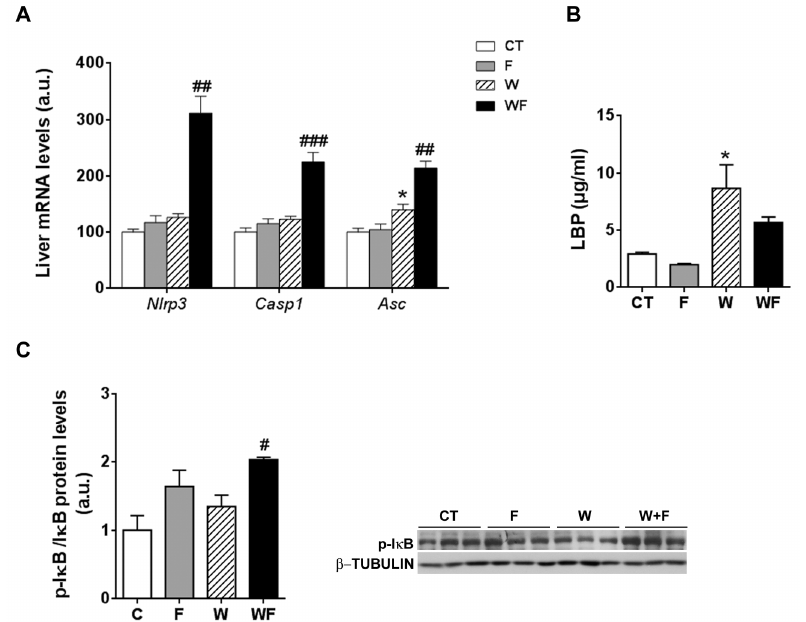
Figure 3. ( A ) Bar plots showing the relative levels of specific mRNAs of the NLRP3 inflammasome complex from Control (CT, mice fed standard solid-chow), Fructose (F, mice fed standard solid-chow plus a 15% fructose solution ad libitum), Western (W, mice fed Western solid-chow), and Western + Fructose (WF, mice fed Western solid-chow plus a 15% fructose solution ad libitum), represented as mean (a.u., arbitrary units) ± SEM of five different liver samples; ( B ) Plasma level of lipopolysaccharide (LPS)-binding protein represented as mean ( µ g/mL) ± SEM of five to six different plasma samples obtained from CT, F, W and WF groups; ( C ) Western-blot of phosphorylated and total I κ B α in liver samples obtained from CT, F, W and WF groups. Representative bands corresponding to three different mice in each group are shown; bar plots show the level of the phosphorylated protein expressed as the mean (a.u., arbitrary units) ± SEM of the values obtained from three to four animals. * p < 0.05 vs. CT values; # p < 0.05, ## p < 0.01, ### p <0.001 vs. W values.